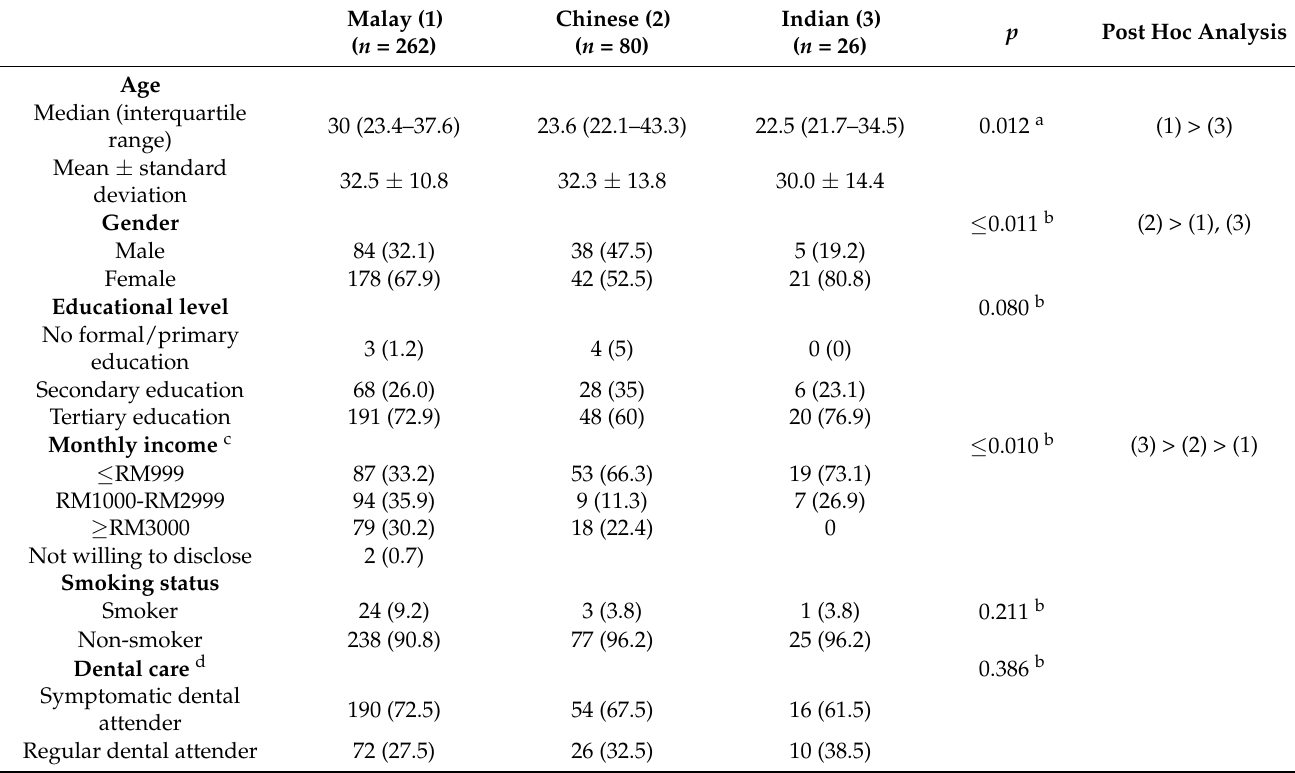
Table 1. Participants’ self-reported socio-demographic data and dental attendance ( n =